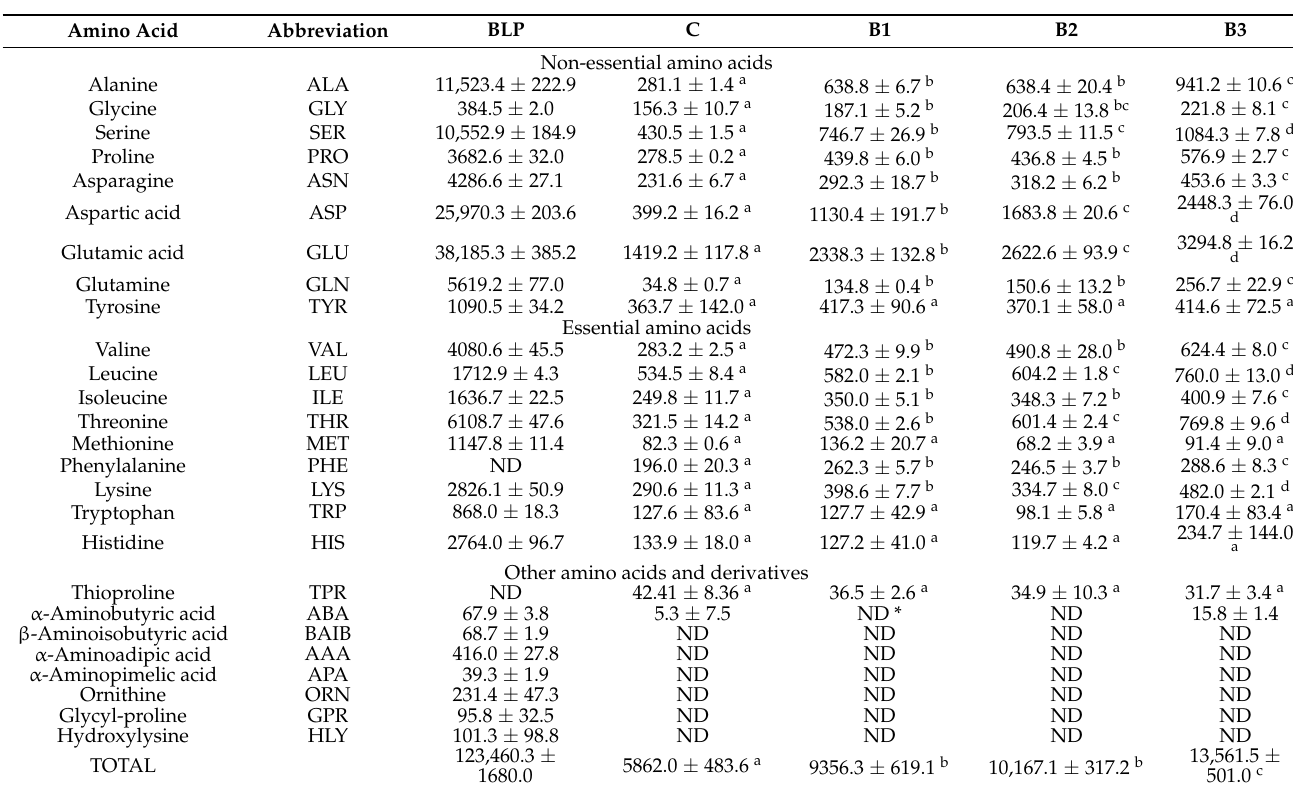
Table 1. Amino acid profile in BLP and BLP fortified GFM extracted using method 1. Data expressed as mean ± SD in nmol/g DM. Different letters in superscript in the same line indicate a significant difference ( p < 0.05) (Fisher’s LSD. ANOVA). C—control, B1—2.5% starch replacement with